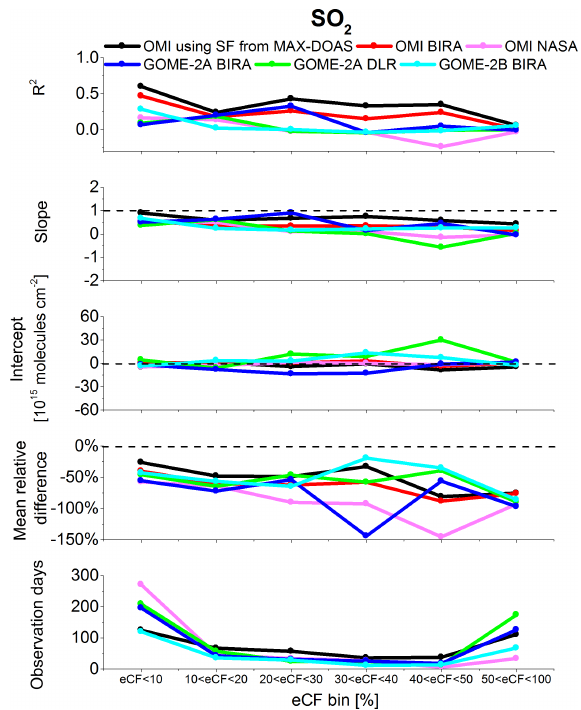
Figure 5. Same as Fig. 3 but for SO 2